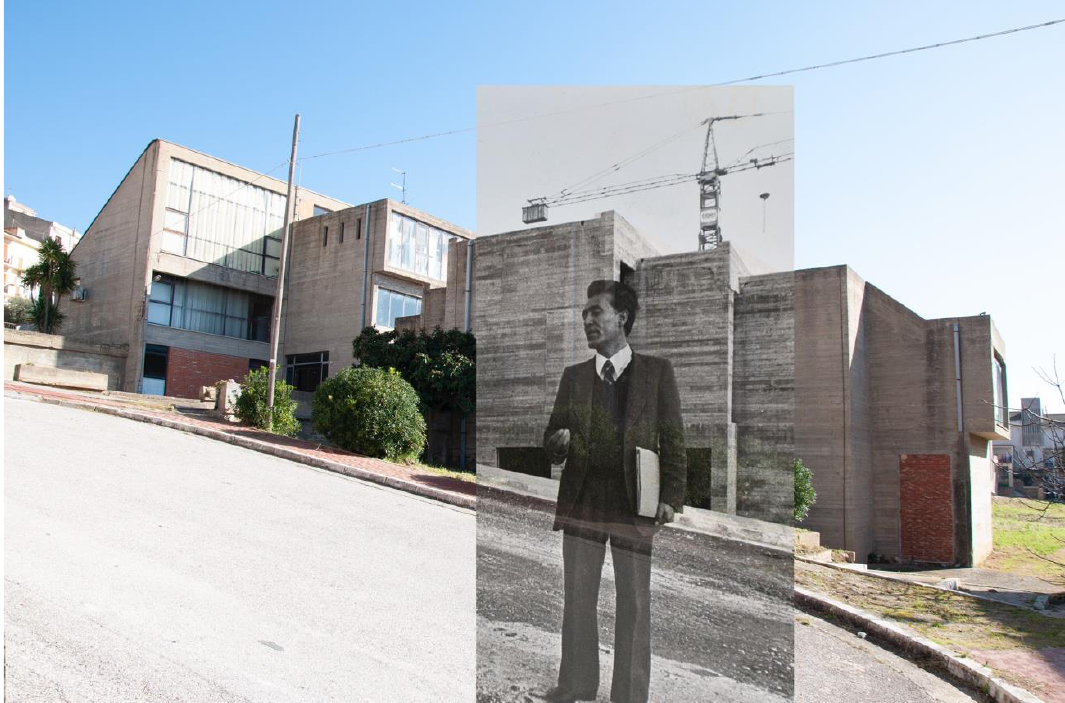
Figure 20. Santa Ninfa. Mayor Bellafiore in front of the Casa del Popolo under construction (Photo: Archivio de L’Ora, Biblioteca Regionale Siciliana “Alberto Bombace”, Palermo) and Casa del Popolo (Photo by the authors, Santa Ninfa 2022).